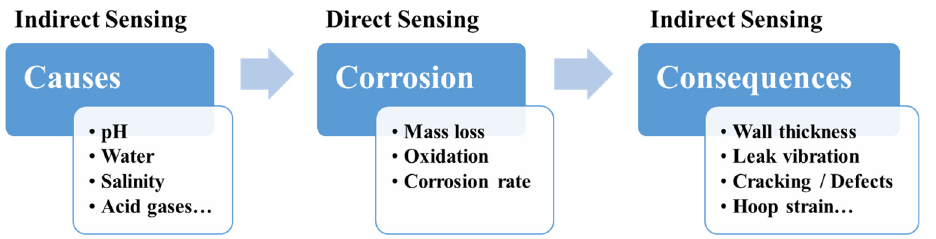
Figure 1. Two categories of corrosion sensors (direct and indirect) to monitor corrosion process from causes to consequences.